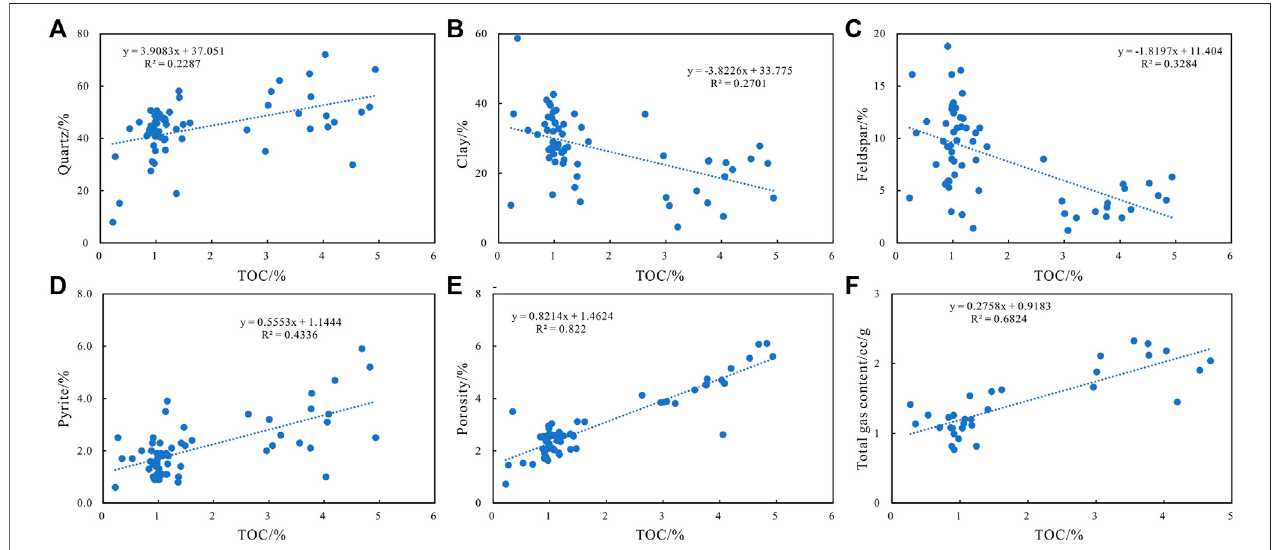
FIGURE 9 | Correlation diagram between TOC, shale mineral components, porosity, and total gas content. Quartz: quartz content, Clay: clay content, Feldspar: feldspar content, Pyrite: pyrite content of the shale samples.